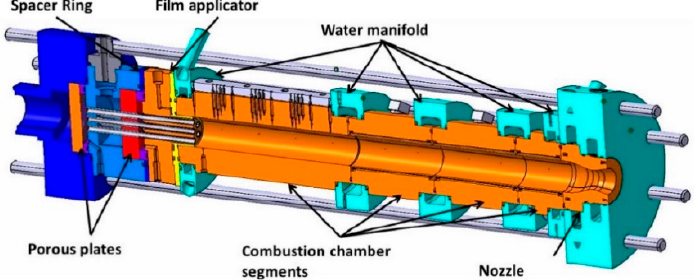
Figure 1. View of the studied thrust chamber [1,2].